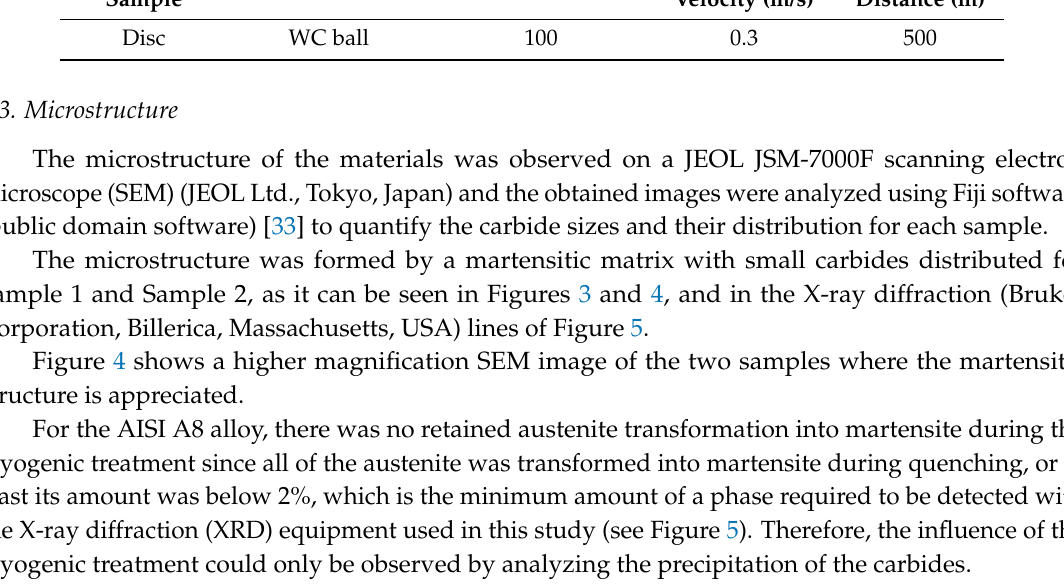
Figure 3. SEM image of the microstructure of the AISI A8 tool steel for Sample 1. Several secondary carbides are identified in a martensitic matrix.